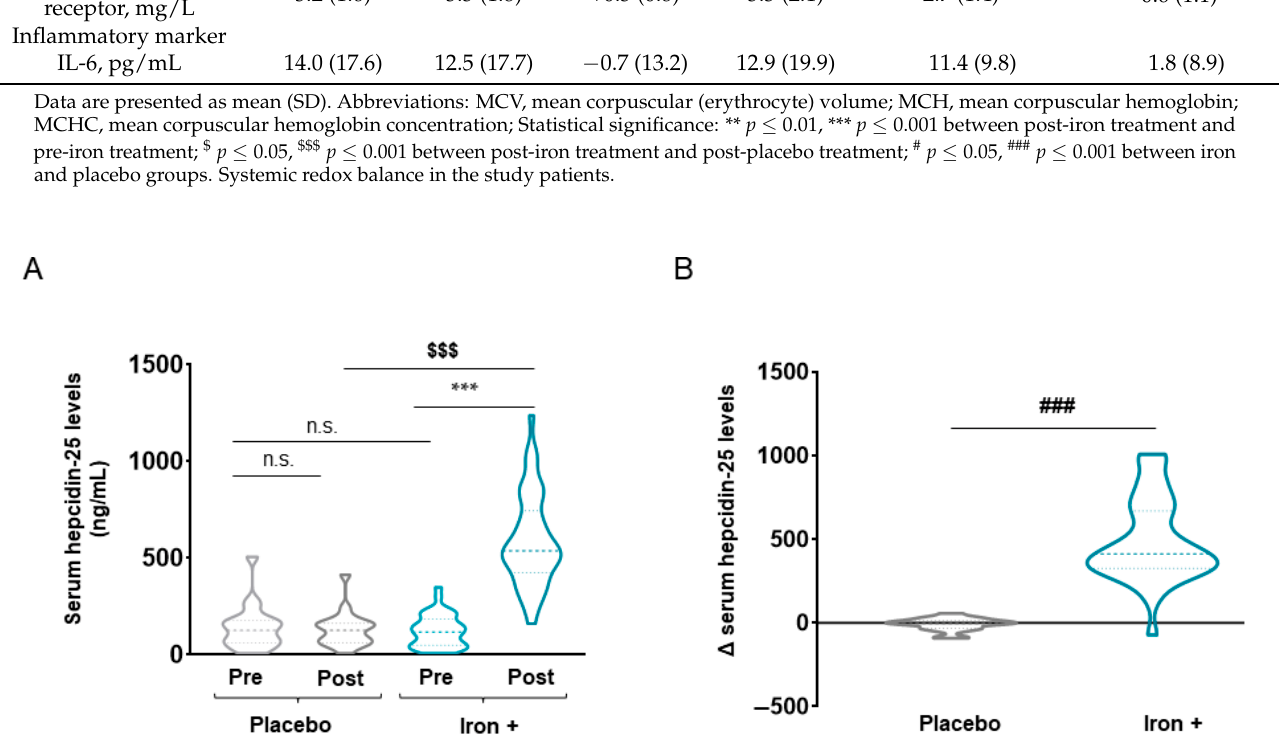
Figure 2. Violin plots of absolute hepcidin-25 levels in serum of all COPD patient groups ( A ) and delta (post-pre) of serum hepcidin-25 levels in placebo and iron-treated groups ( B ). The dashed line represents the median and the dotted lines the interquartile ranges. Statistical significance: n.s., no significance; $$$ p < 0.001 between post-iron treatment and post-placebo treatment, *** p < 0.001 between post-iron and pre-iron treatment; ### p < 0.001 between iron and placebo treatment.